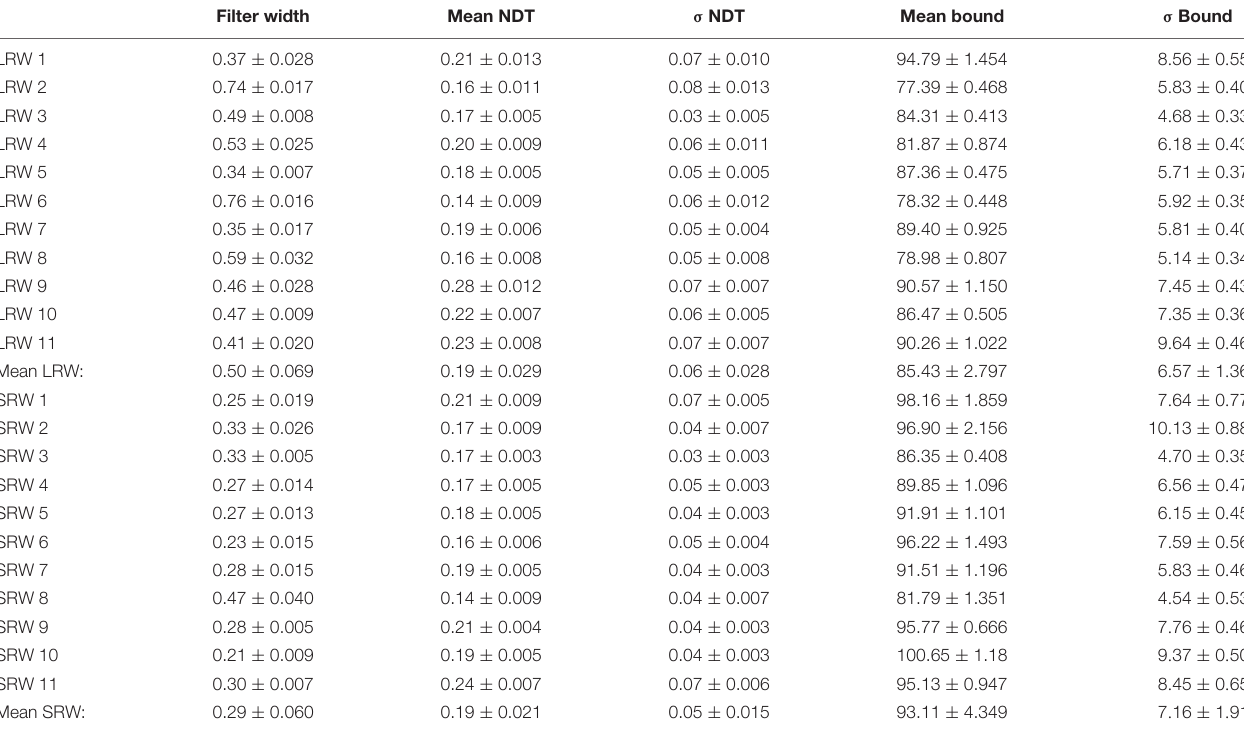
TABLE 1 | Subject-specific model parameter estimates ± SE for each condition (LRW, long response window; SRW, short response window). Subjects identified by number. Filter width σ